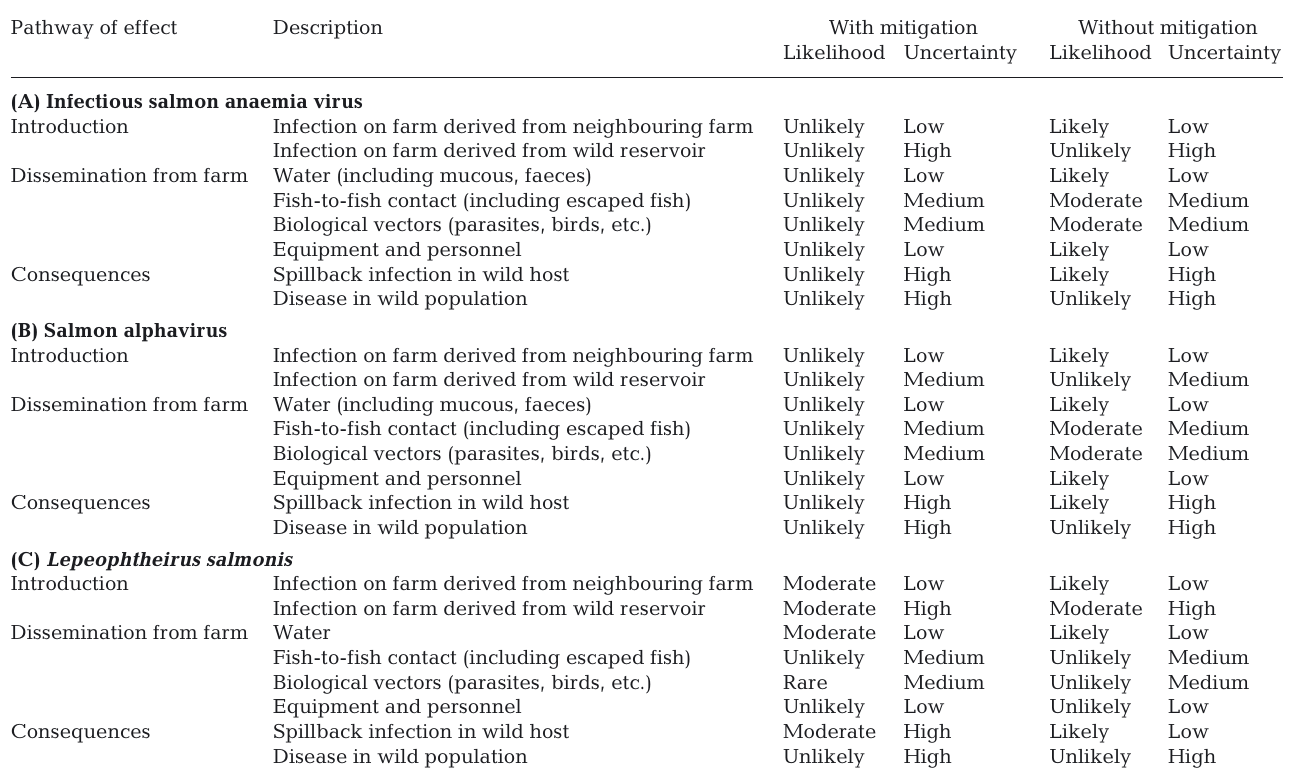
Table 4. Estimates of likelihood and uncertainty surrounding the effects of mitigation on risk pathways associated with the introduction, dissemination and consequences of (A) infectious salmon anaemia virus, (B) salmon alphavirus and (C) the salmon louse Lepeophtheirus salmonis in mariculture. See Table 1 for mitigation